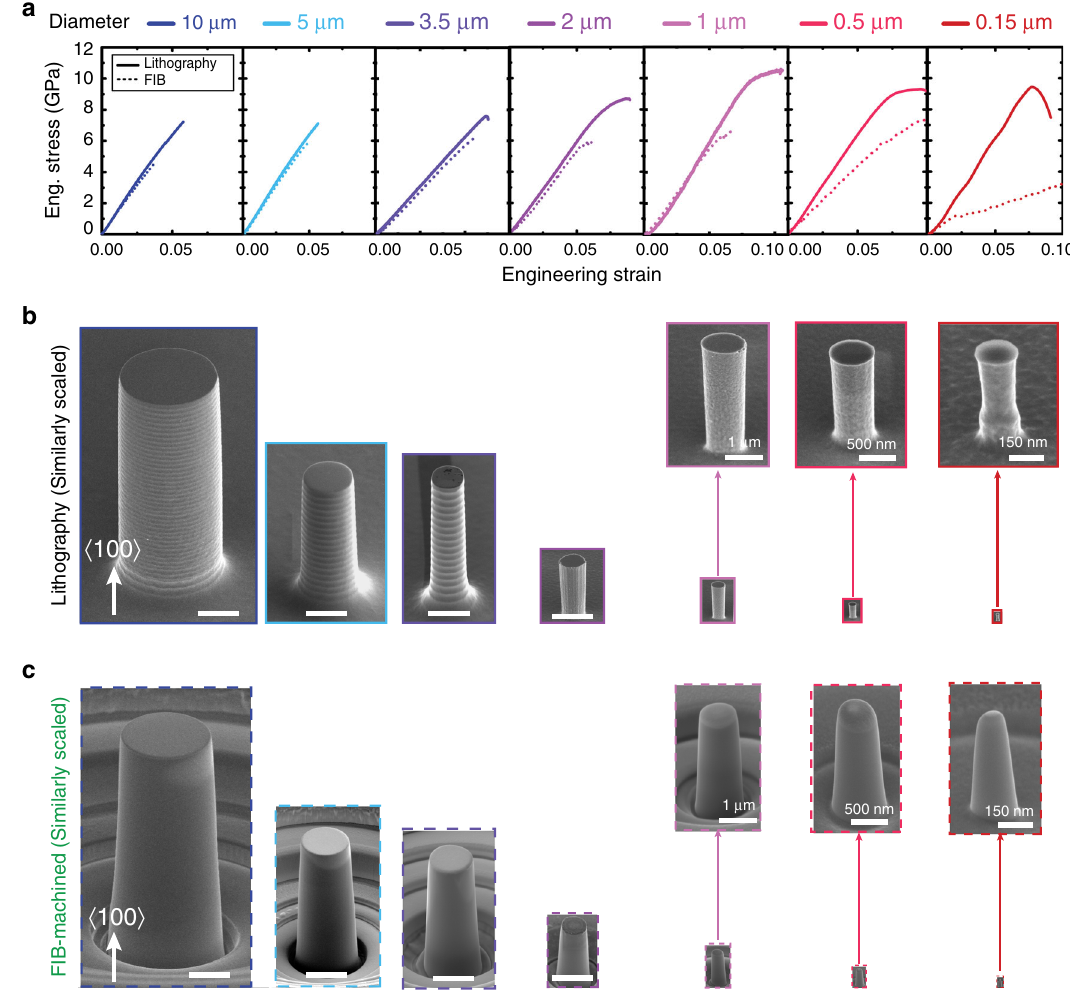
Fig. 1 Microcompression of Si pillars fabricated by lithography processing and focused ion beam (FIB) machining at ambient temperature. a Representative fl ow curves of lithographic (solid lines) and FIB-machined (dashed lines) pillars under a constant strain rate of 5 × 10 − 4 s − 1 . b Similarly scaled secondary electron (SE) images of pillars with various diameters fabricated by lithography technique prior to microcompression. c Similarly scaled SE images of FIB-machined pillars with various diameters. Scale bar, 3 μ m.